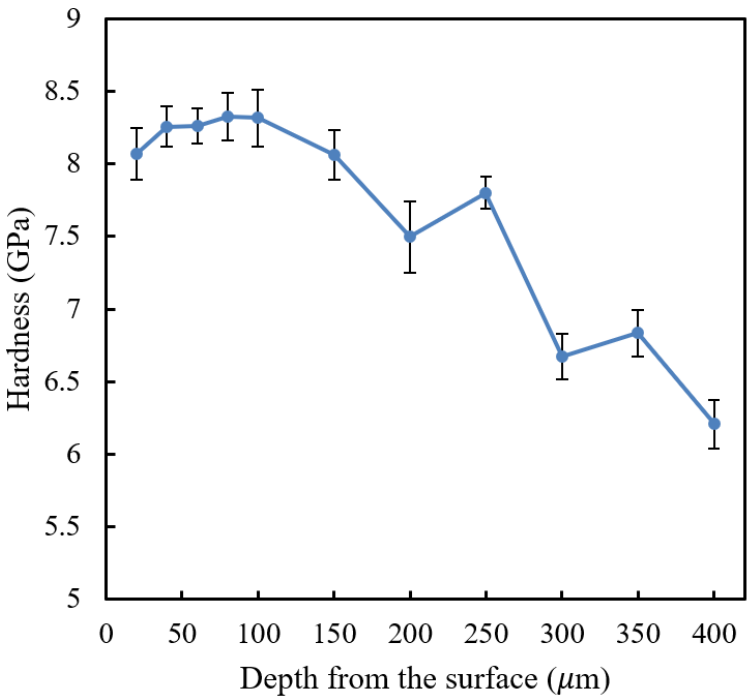
Figure 9. Berkovich nano hardness profile showing a slight decrease in hardness near the top surface of the laser-hardened 420SS.